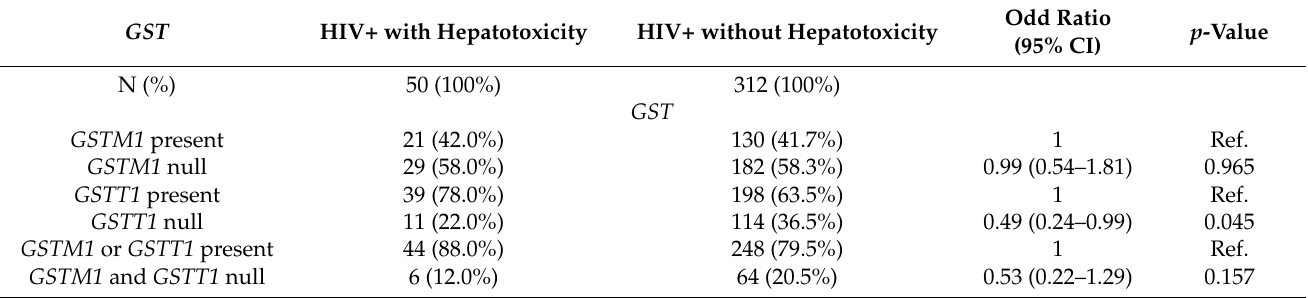
Table 3. Genotypic distributions of GST s and HLA in PLHIV with and without